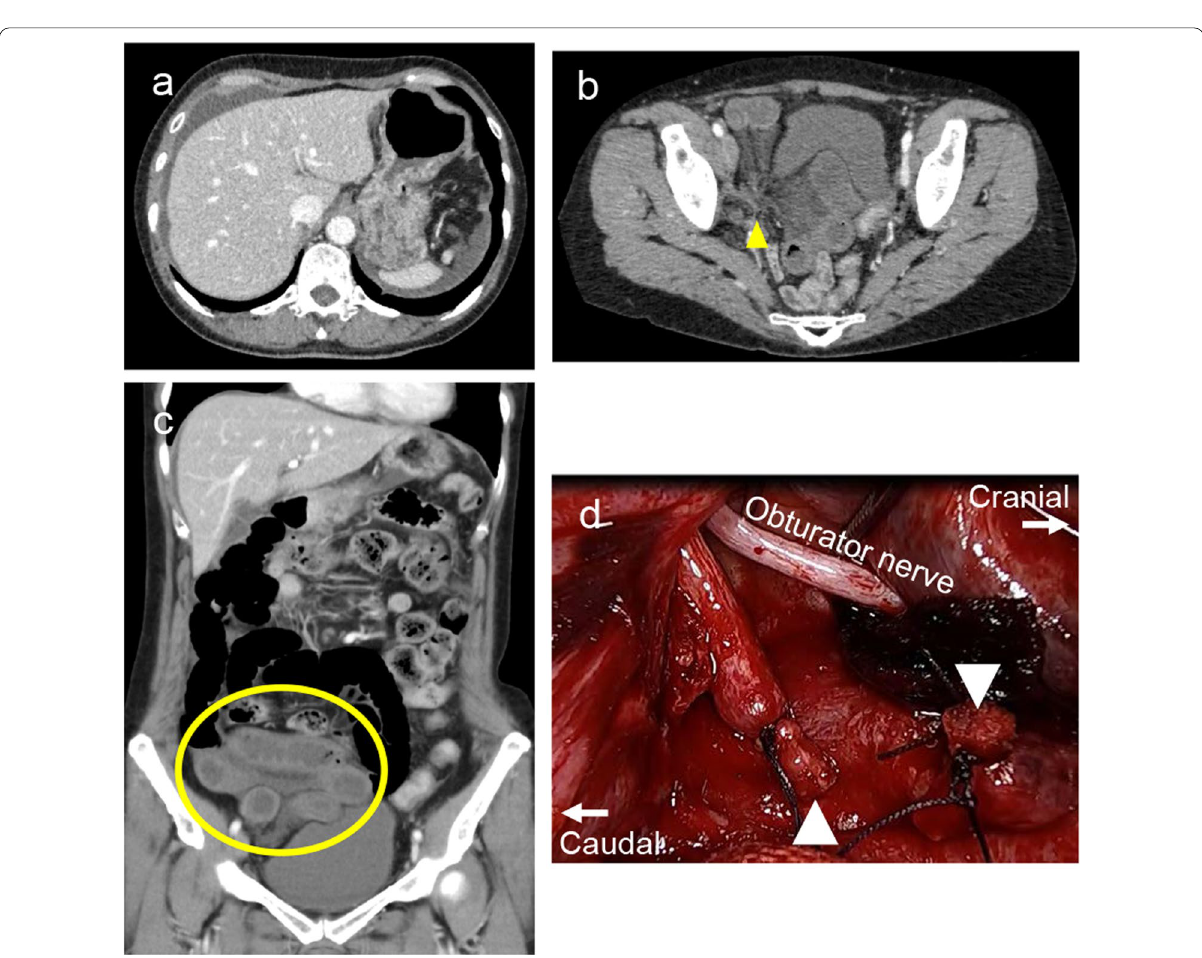
Fig. 3 Abdominal CT scan images before urgent surgery ( a – c ) and a laparoscopic view after resection of umbilical artery ( d ) of the case 2 patient. a Massive ascites are found on the liver surface. b and c Axial ( b ) and coronal view ( c ) of the strangulated small bowel. The yellow arrowhead and circle denote the strangulated origin and edematous mesentery and intestine. d Umbilical artery stump (white arrowhead) after resection of the incarcerated small bowel and a